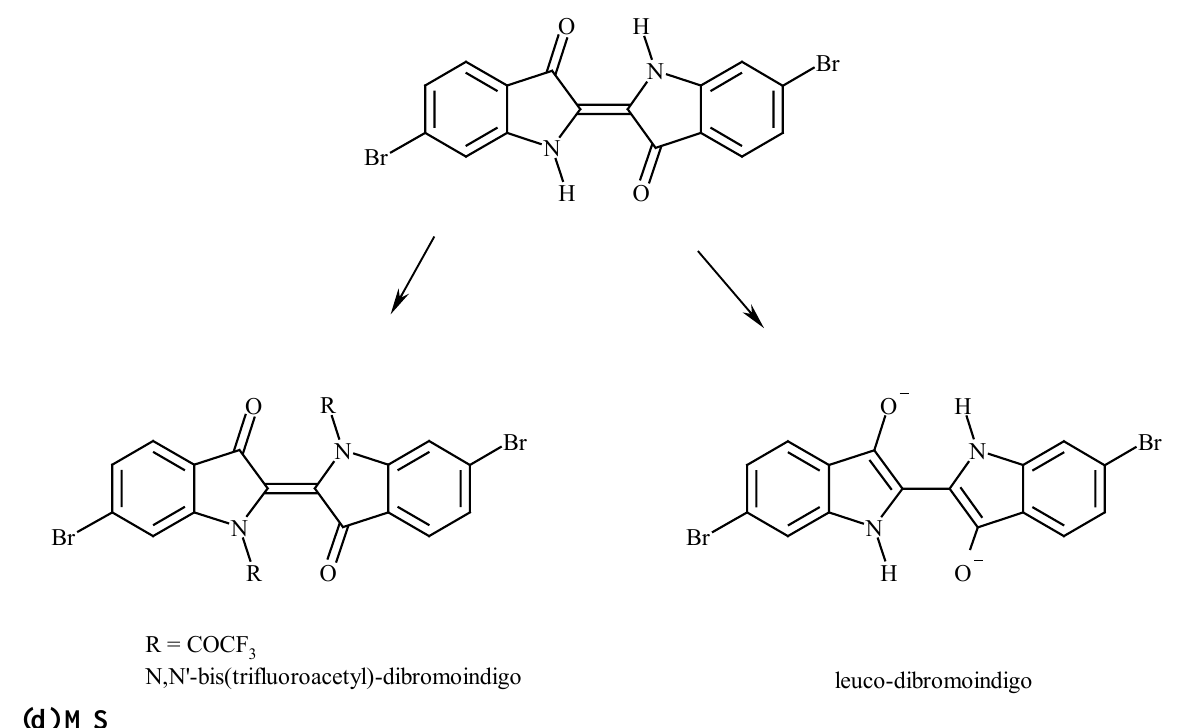
Figure 6. Derivitisation of dibromoindigo for NMR